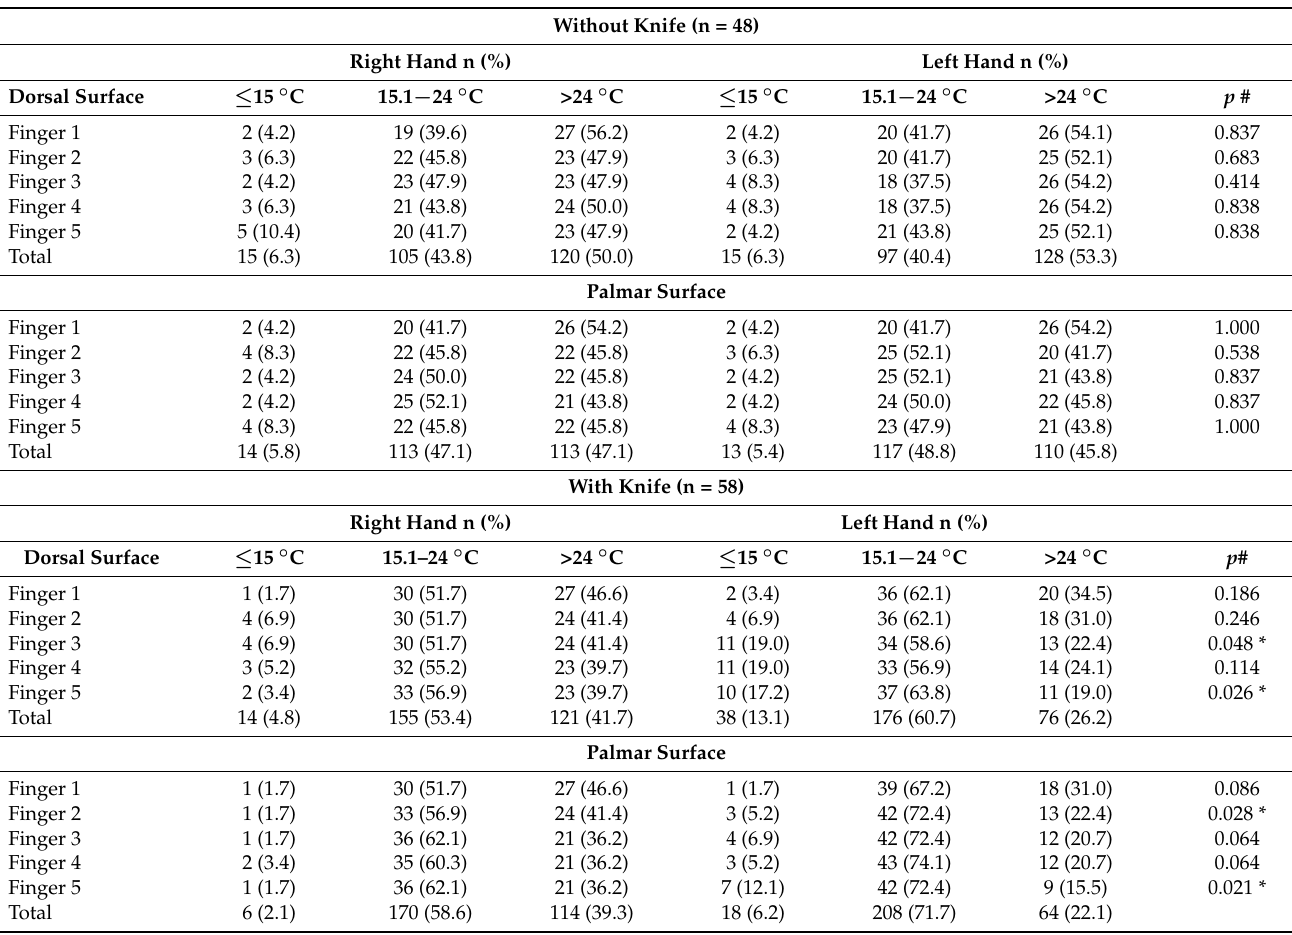
Table 3. Classification and comparison between right and left fingers temperatures, according to ISO 11079:2007